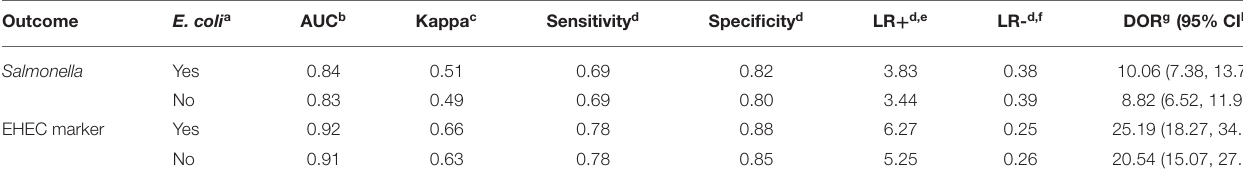
TABLE 3 | Performance measures for the conditional random forest models displaying the relationship of the pathogen detection outcomes ( Salmonella presence and EHEC marker detection) with the land use, weather, sampling site characteristics, and water quality predictors with generic E. coli level included and excluded as a predictor.